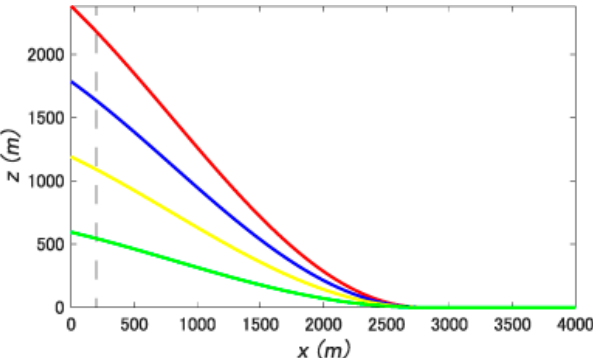
Figure 4. Slopes used in the simulation for revealing the effect of particle diameter d . The broken line shows the particle release position. The steepness of the slope at the release position was 47° ( red ), 37° ( blue ), 26° ( yellow ), and 15° ( green ) and the release heights were 2190, 1640, 1090, and 550 m, respectively.